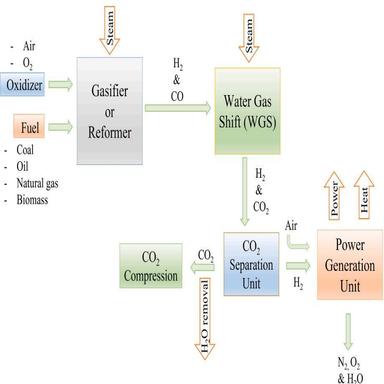
Shows the schematic representation of post-combustion process.